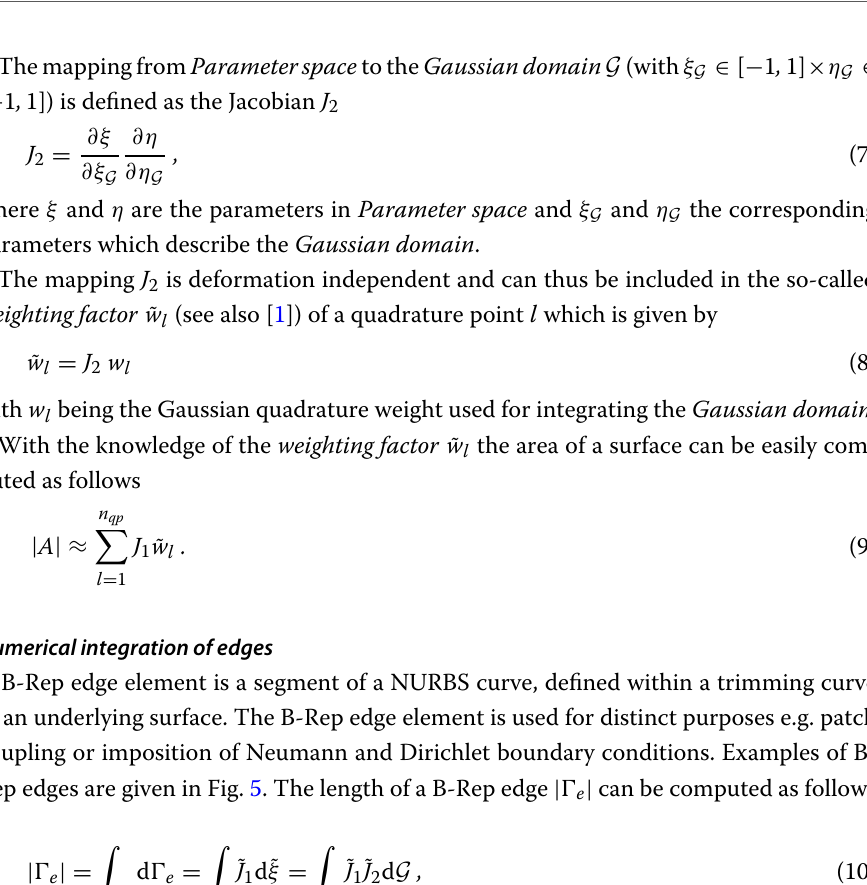
Fig. 4 B-Rep model of a trimmed surface with the respective base vectors for the surface and the edge in Geometryspace